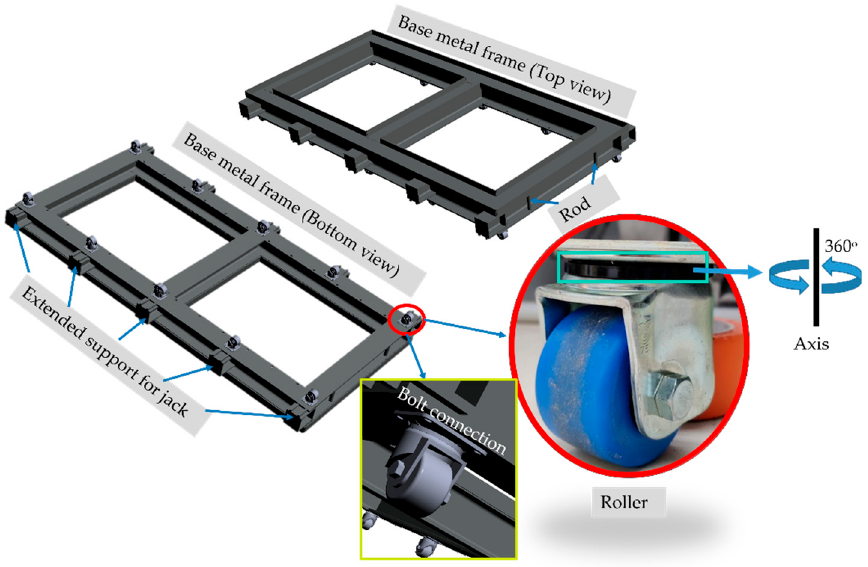
Figure 2. Metallic frame used at the base of the building